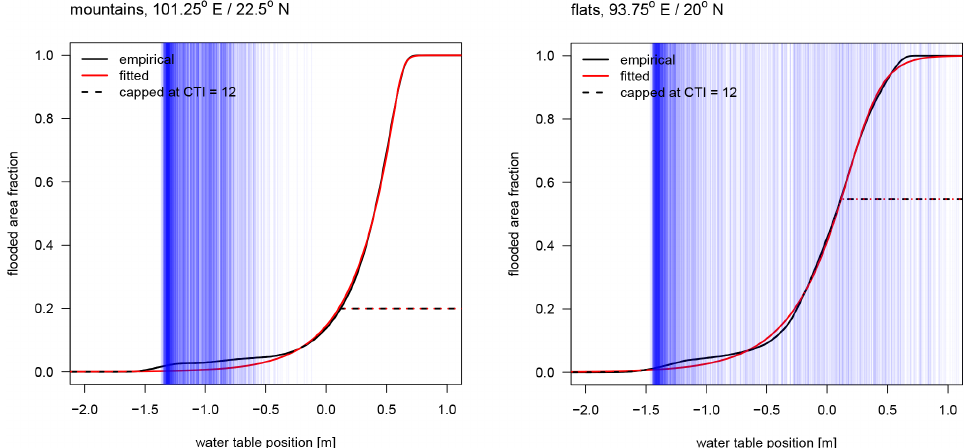
Figure 2. “Empirical” (black) and fitted (red) curves relating the grid cell mean water table position ( (cid:48) ) to the flooded fraction of this grid cell. A mountainous grid cell (left, centred at 101.25 ◦ W, 22.5 ◦ N) and a flatland grid cell (right, centred at 93.75 ◦ W, 20 ◦ N) are shown as examples. Vertical blue lines illustrate (cid:48) for each month as simulated by LPX for the period 1901–2012 (see Sect. 5.2). Table 1. DYPTOP model parameters. Parameter Value Description/Reference M 8 TOPMODEL parameter, Eq. (2) CTI min 12 Minimum CTI for floodability, Eq. (3) λ 2 Exponential correction factor for effective soil depth, Eq. (11) N 18 Minimum number of months with inundation, Eq. (13) r 0.01yr − 1 Maximum relative peat expansion/contraction rate, Eq. (14) POAET ∗ 1.0 Minimum precipitation-over-actual-evapotranspiration, Fig. 3 C ∗ peat 50kgCm − 2 Minimum peat amount, Fig. 3 d C ∗ peat Minimum annual peat accumulation, Fig. 3 d t